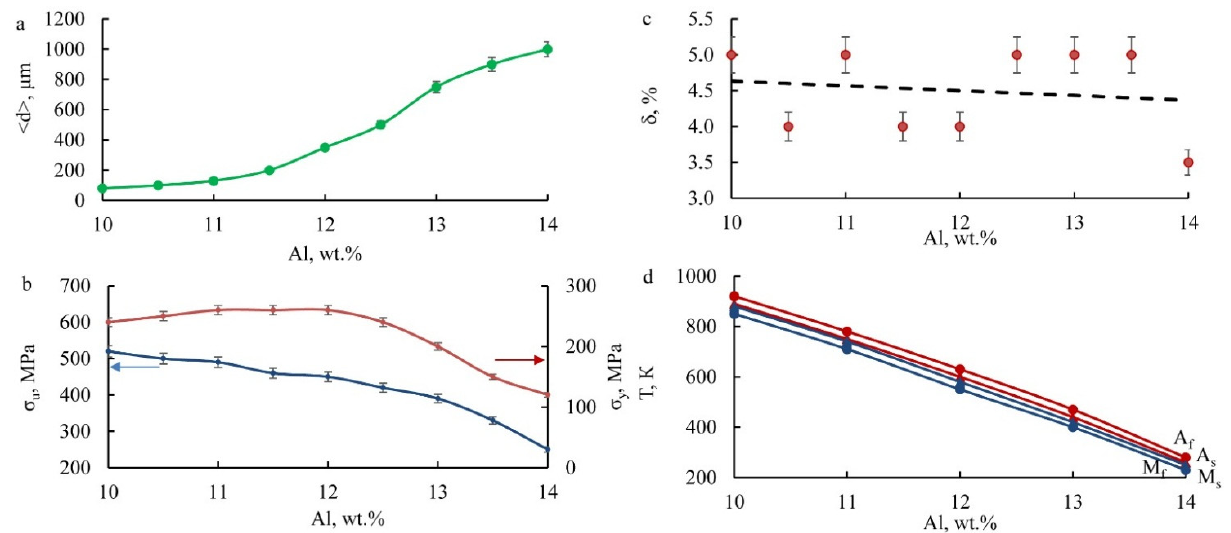
Figure 5. Concentration dependences of ( а ) average grain size <d> on the aluminum content, ( b ) limits of strength σ u (blue line) and yield σ y (red line), ( c ) elongation δ on the aluminum content (Red dot indicates measurement error) and ( d ) temperatures of the start and finish of forward (M s , M f ) and reverse (A s , A f ) TMT in Cu-xAl-3Ni alloys.